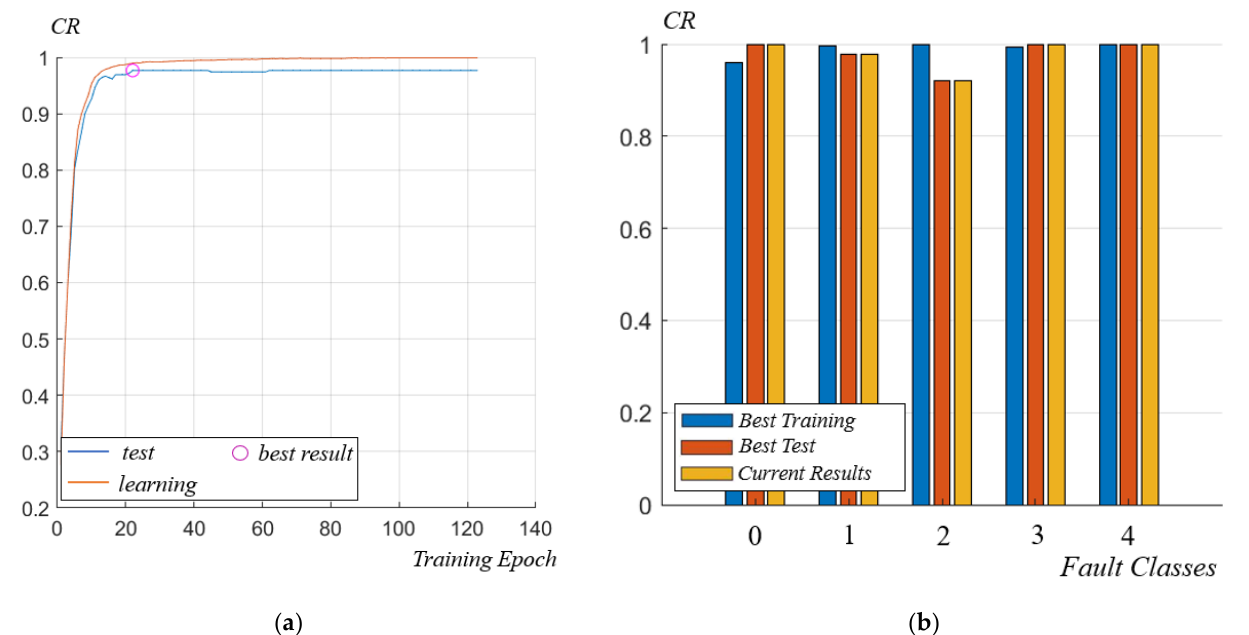
Figure 19. Classification results: ( a ) classification rate obtained during the learning phase (red line) and classification rate obtained during the test phase (blue line); ( b ) classification performance for each fault class.